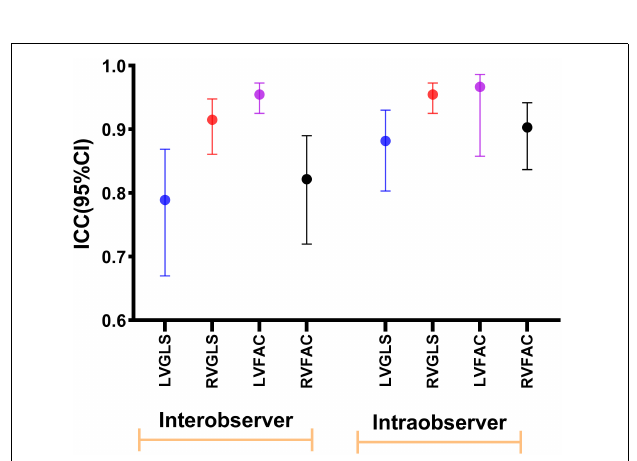
FIGURE 7 | Intraobserver and interobserver reproducibility of LVGLS, RVGLS, LVFAC, and RVFAC represented as ICCs and 95%